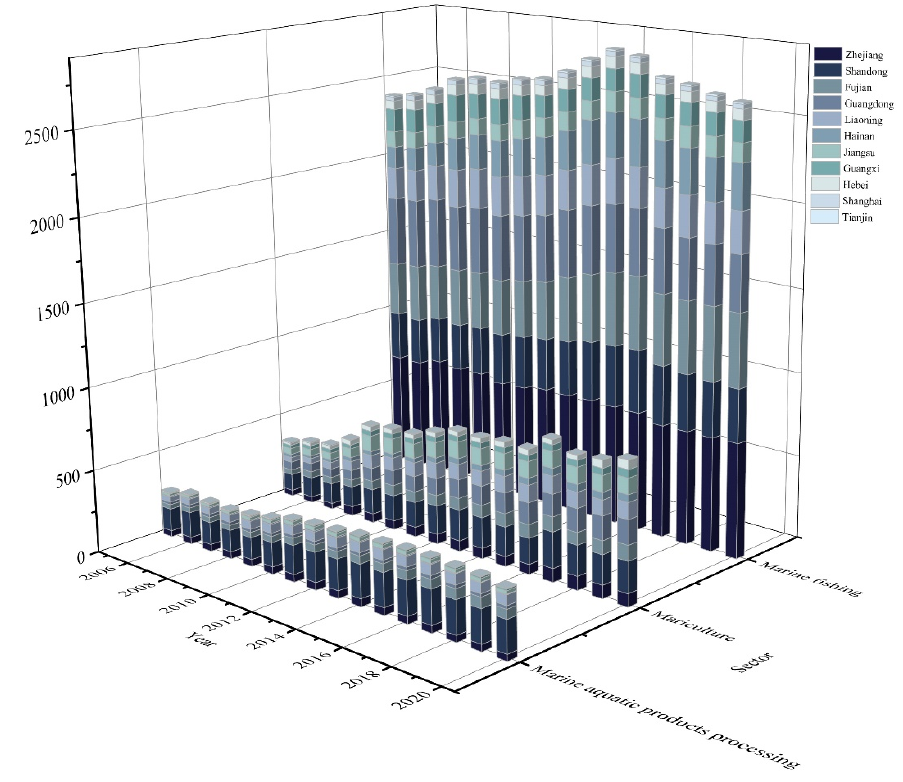
Figure 3. Marine fisheries’ CO 2 emissions in three main sectors ( 10 (cid:2872)